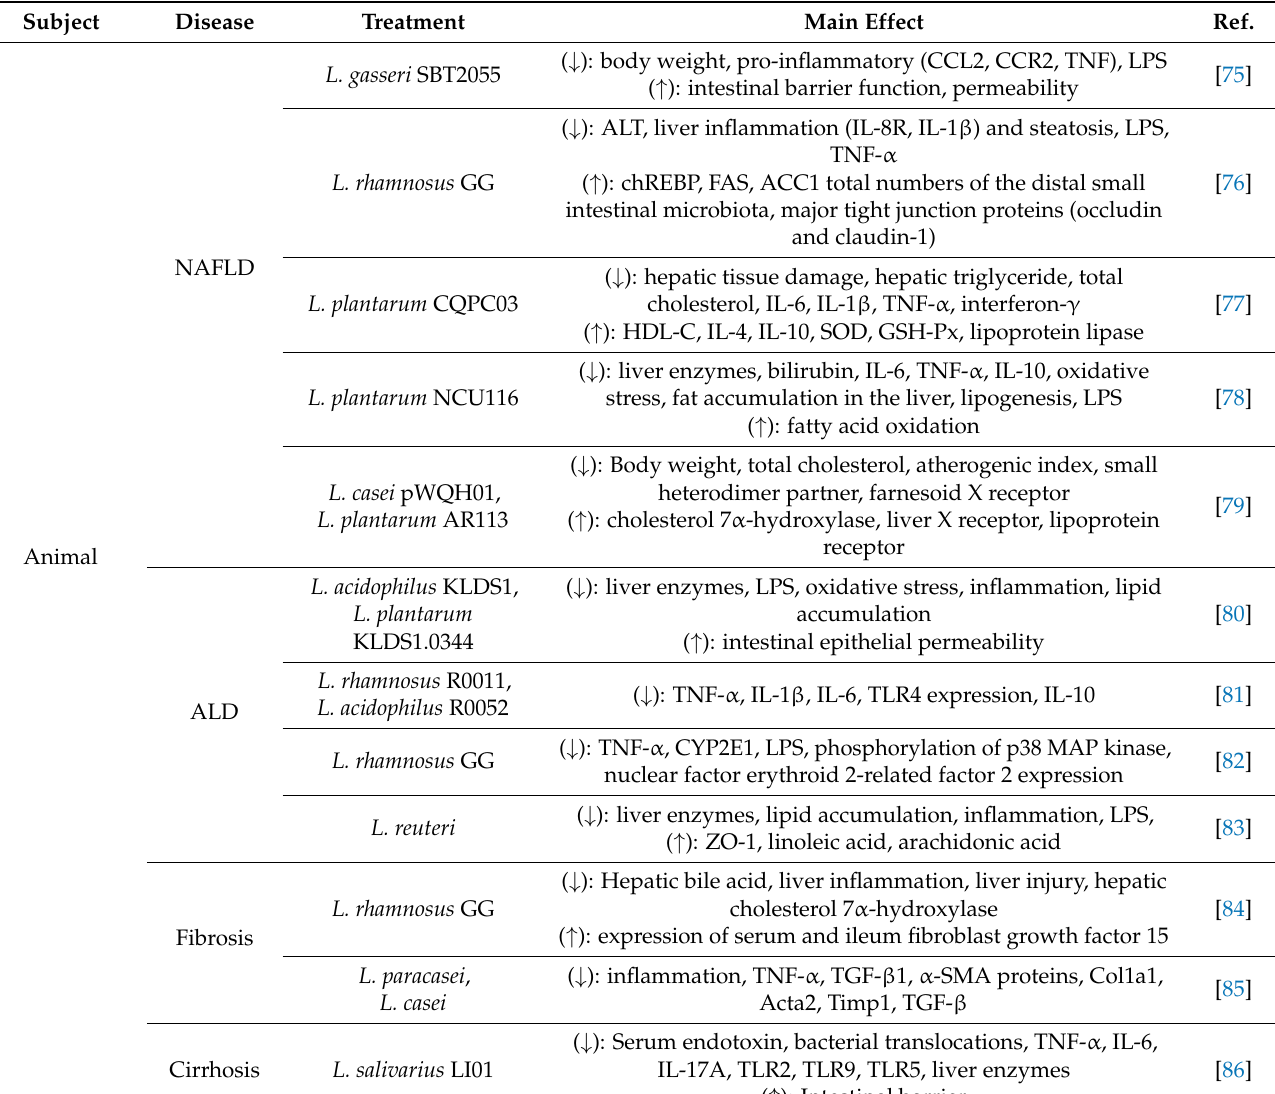
Table 2. Use of Lactobacillus as probiotics for liver diseases. Treatment Main Effect